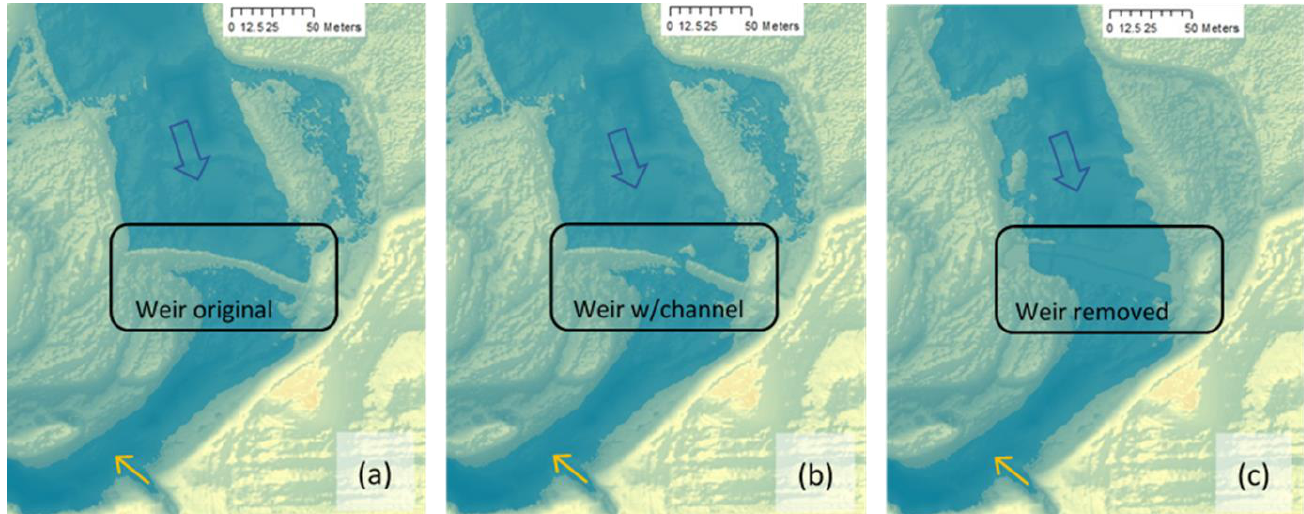
Figure 5. Water-covered area for weir no. 1 with the following configurations: ( a ) original form, ( b ) with a channel across, and ( c ) fully removed. The simulated flow is 6 m 3 /s. The blue arrow shows the flow direction. The yellow arrow indicates the location of the hydropower plant outlet and thus the end of the bypass section.